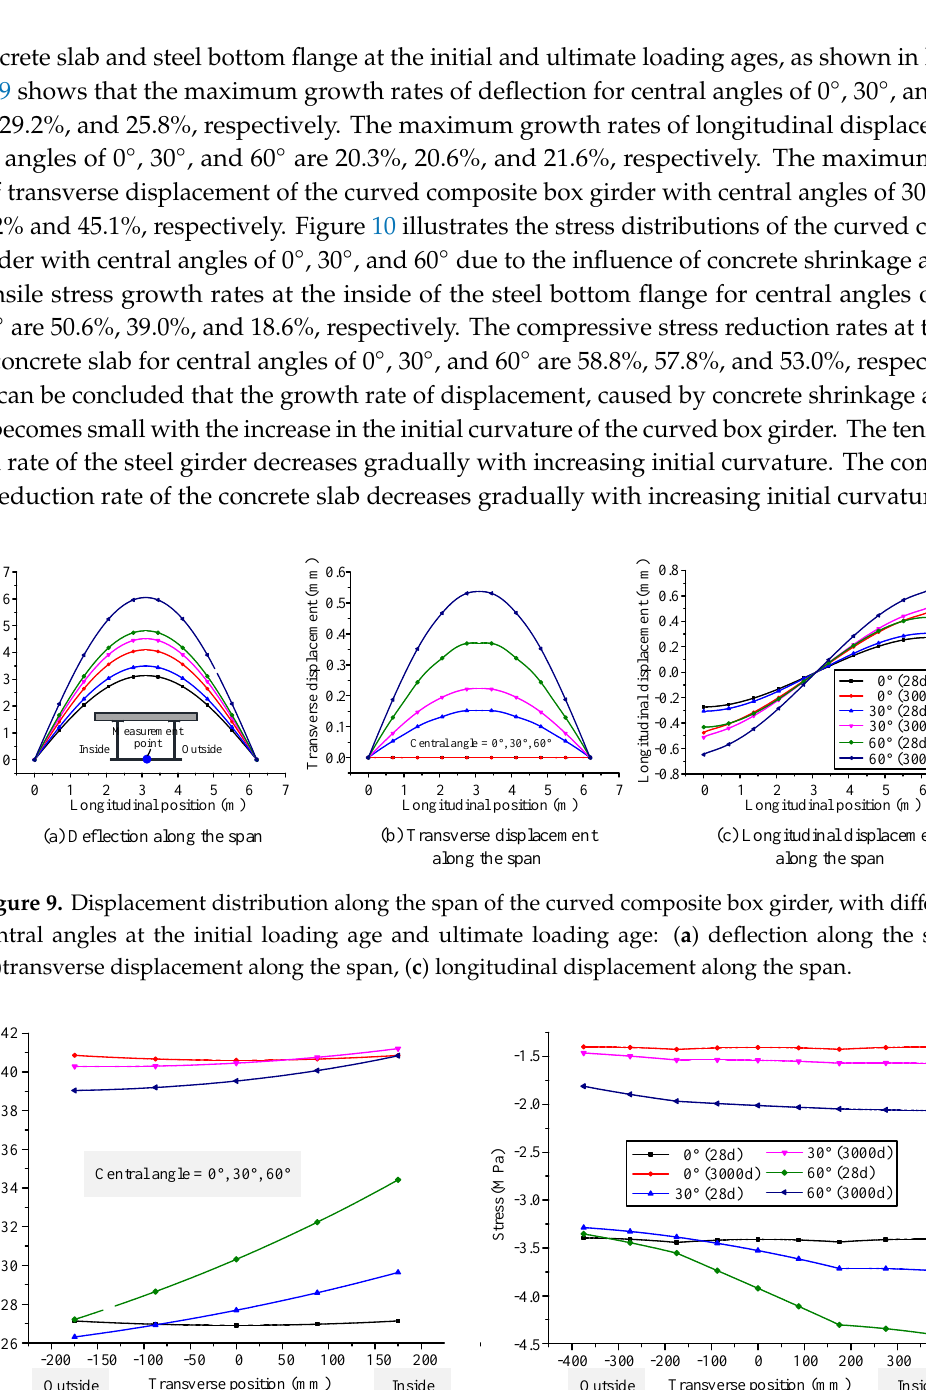
(a) Normal stress in the steel girder (b) Normal stress in the concrete slab Figure 10. Normal stress distribution along the transverse direction of the curved composite box girder, with different central angles at the initial loading age and ultimate loading age: ( a ) normal stress in the steel girder, ( b ) normal stress in the concrete slab.